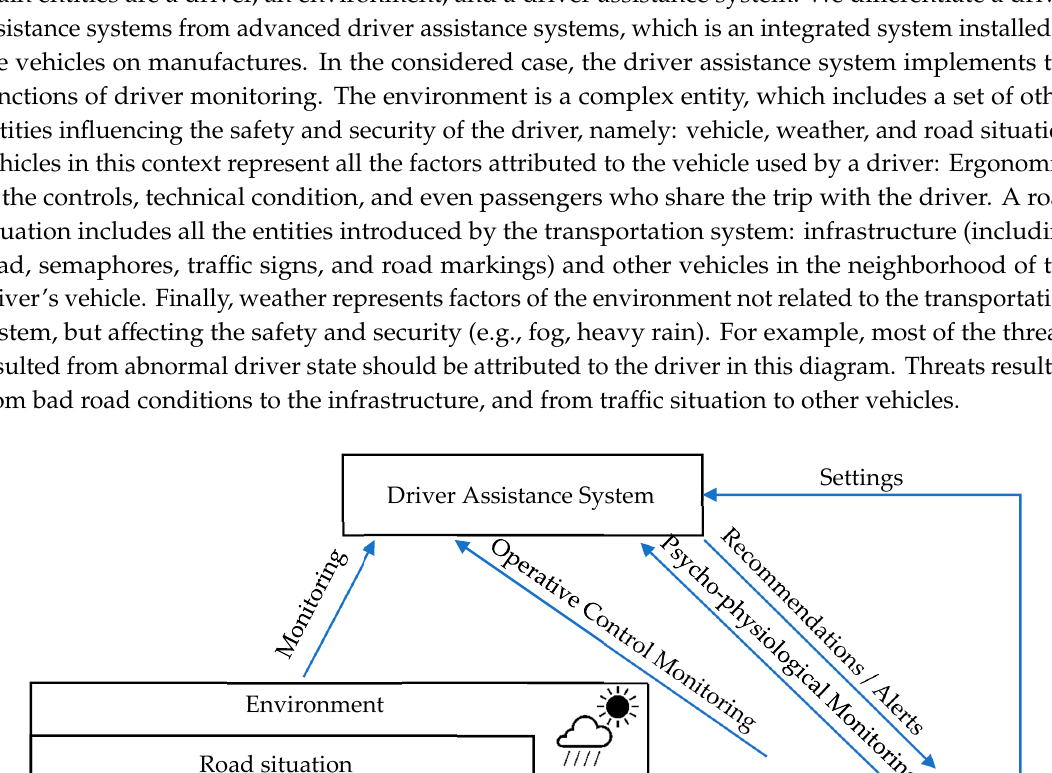
Table 1. Vulnerability classification for driver monitoring systems.